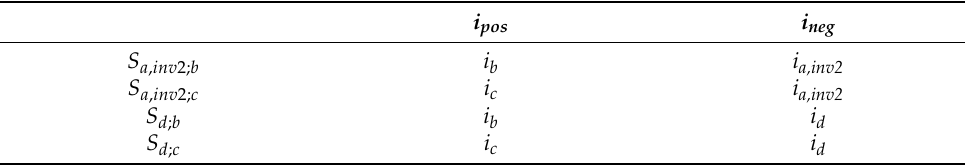
Table 2. Sector-dependent currents.